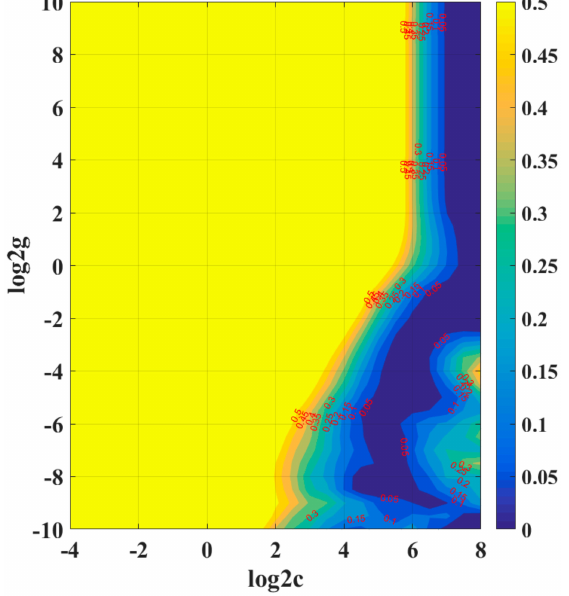
Figure 11. Determination of optimal parameters using a progressive search algorithm when the upper value prediction is carried out.